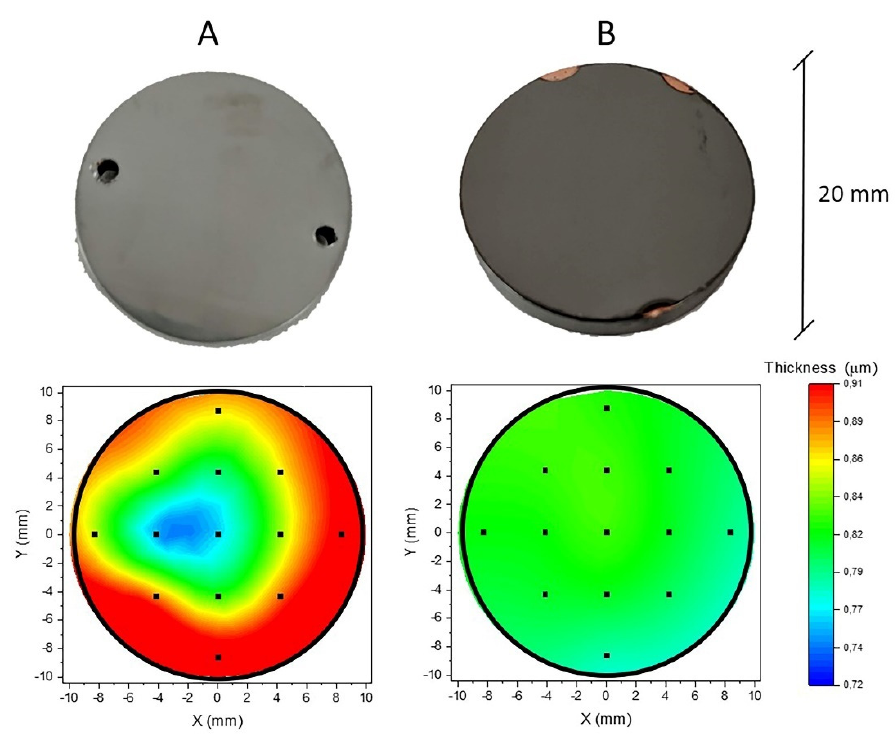
Figure 1. Optical images ( above ) and respective thickness contour plots ( below ) of electrodepos-ited ( A ) and magnetron-sputtered ( B ) samples. The black dots in the contour plots depict the grid of points checked by XRF.